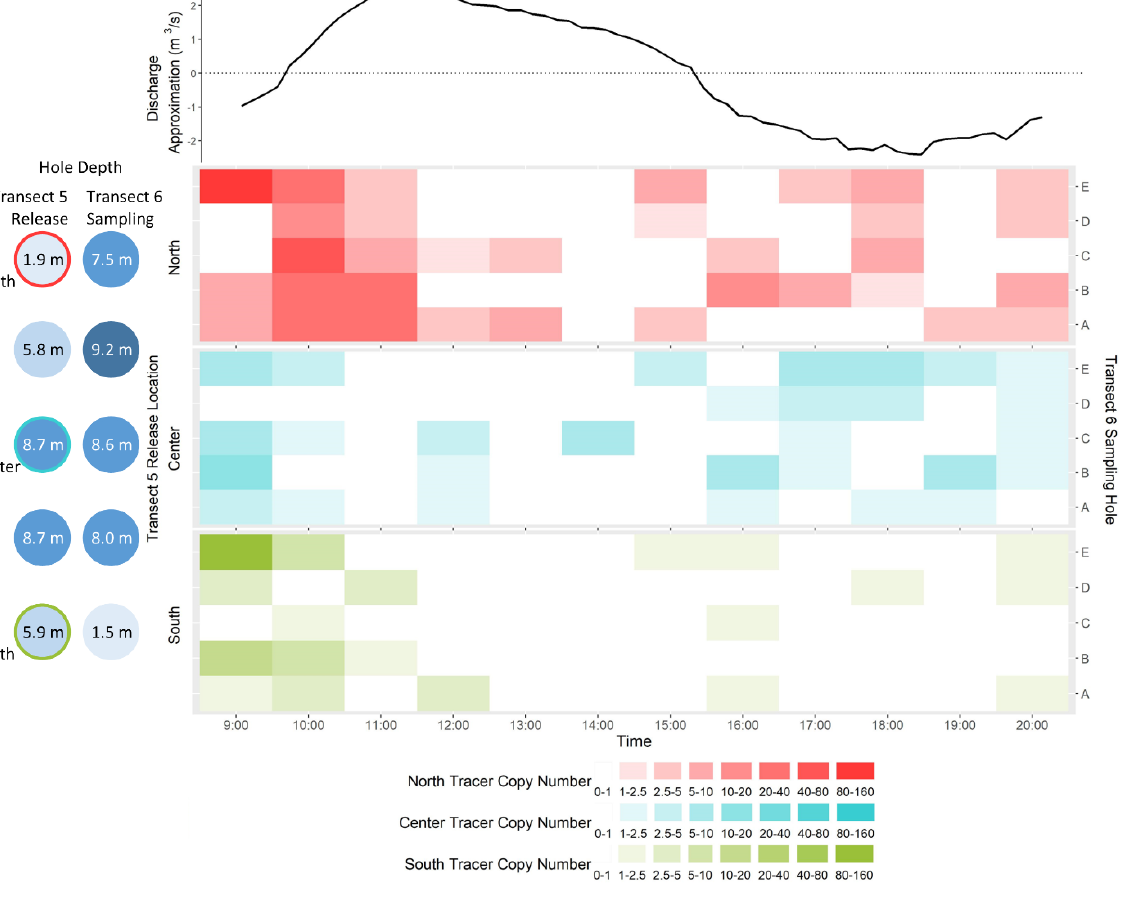
Figure 6. Heat maps of mean DNA copy number per qPCR reaction for each tracer in samples collected from the 2020 tidal time series. Distinct tracers were released into either the north-most (red, top panel), center (blue, middle panel) or south-most (green, bottom panel) holes in transect 5 approximately 1 h before sampling began at transect 6. Samples collected from all transect 6 holes ( A – E, right axis ) at each timepoint (9:00 – 20:00) were tested for all three tracers. Falling tide, as determined by ADCP measurements, was from 9:50 to 15:30. A discharge approximation (m 3 /s) was calculated as the sum of flow speed (m/s) at each depth interval (0.25 m) for a 1 m transect under the ADCP. Negative values denote upstream flow. The depths of holes at transects 5 and 6 are presented on the left to indicate the location of the main channel.